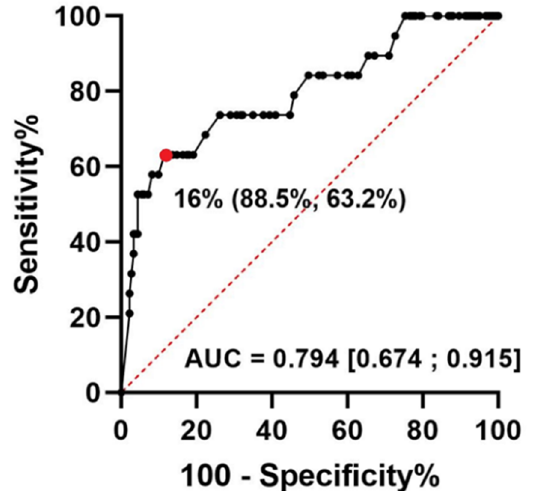
Figure 4. Receiver operating characteristics curve for glycosylated ferritin in adult-onset Still’s disease flare. Abbreviations: AUC, area under curve; (specificity %, sensibility %); (Confidence intervals at 95%). The red dot is the best threshold value determined using the Youden index.